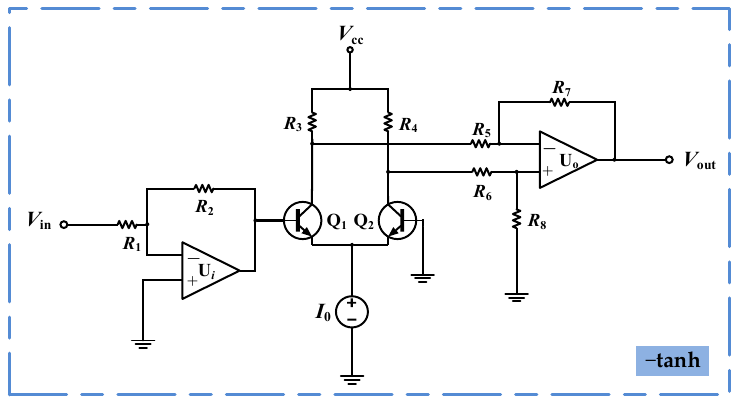
Figure 1. Circuit scheme of inverting hyperbolic tangent function. The obtained simulated results of the inverting hyperbolic tangent circuit using Pspice are shown in Figure